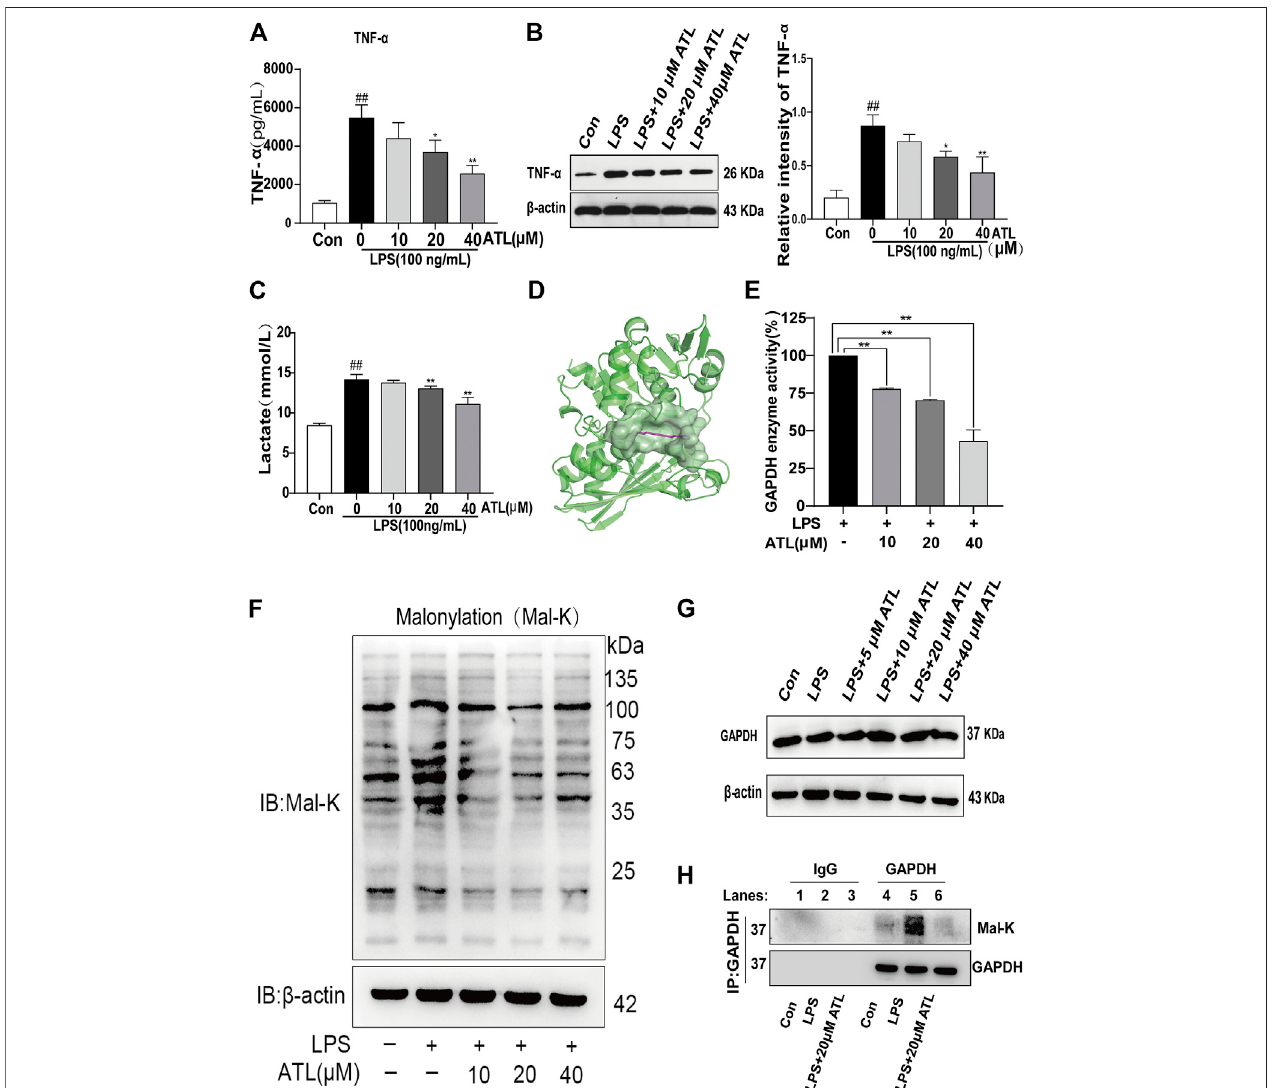
FIGURE 5 | ATL targets GAPDH to inhibit the in fl ammatory process (A) TNF- α levels in the supernatant of RAW264.7 cells were measured using ELISA (enzyme linked immunosorbent assay) (B) TNF- α levels in the lysate of RAW264.7 cells were measured using western blotting (C) Lactate levels in the supernatant of RAW264.7 cellsweremeasuredusingalactateassaykit (D) MoleculardockingofATLwithGAPDH (E) GAPDHenzymeactivityinthelysateofRAW264.7cellswasmeasuredusing aGAPDHenzymeactivitykit (F) Westernblotanalysistodeterminelysinemalonylation(mal-K)inthelysatesofRAW264.7treatedwithLPS(100 ng/ml)for24 h (G) GAPDHexpressioninLPS-treatedRAW264.7cellswasanalyzedusingwesternblotting (H) ImmunoprecipitatedGAPDHfromthecontrol,LPS-treated(100 ng/ml),and LPS (100 ng/ml) + ATL (20 μ M)-treated RAW264.7 cells and samples probed with an anti-mal-K antibody (lower panel). GAPDH expression in the immunoprecipitated (upper panel) samples was also examined. Data were obtained from three independent experiments and are presented as the mean ± SEM. Data were analyzed using one-way ANOVA, n (cid:1) 3. # p < 0.05, ## p < 0.01 compared to the control group. * p < 0.05, ** p < 0.01 compared to the LPS (100 ng/ml) + 0 μ M ATL group.